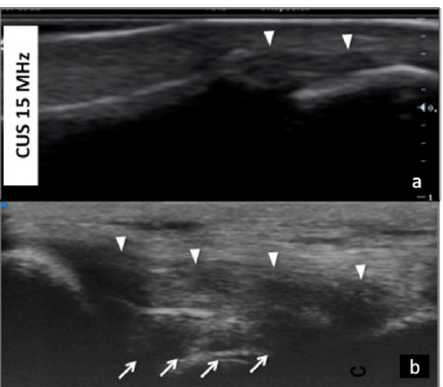
Figure 6. Collateral ligaments of interphalangeal joints: comparison between 50 MHz probes in ( a ) and 15 MHz CUS (arrowheads) in ( b ). In ( a ), UHFUS gives a more detailed and magnified representation of both deep (white arrows) and superficial (white arrowheads) components of the ligament.